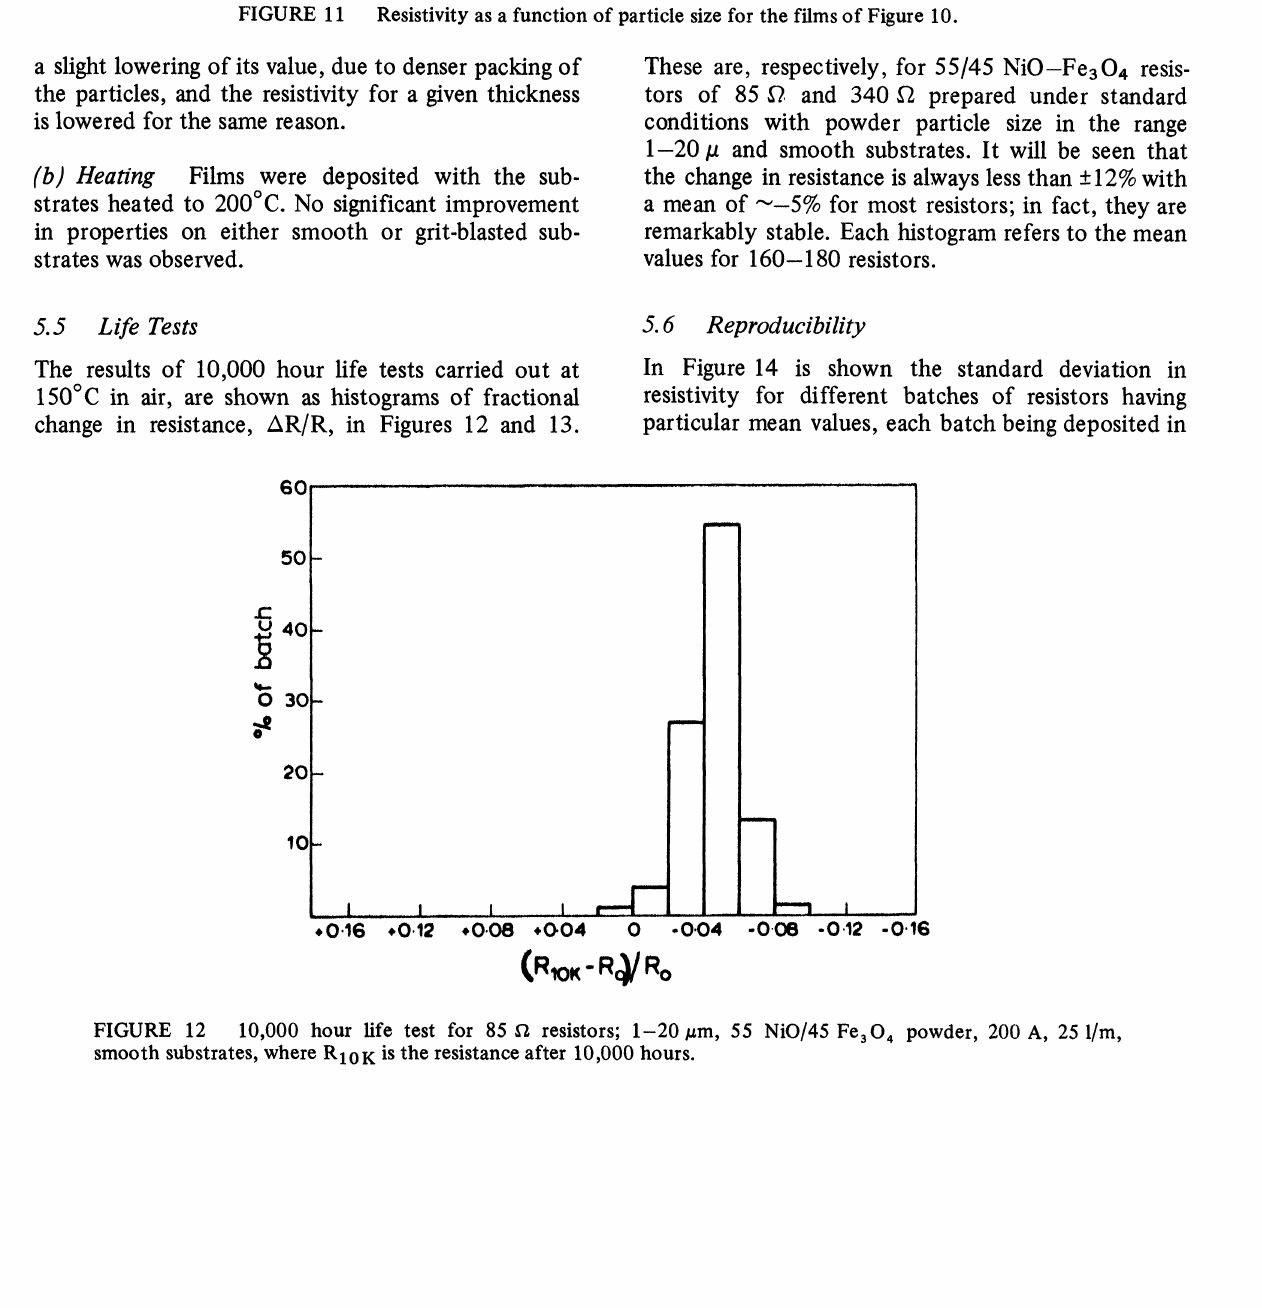
FIGURE 12 10,000 hour life test for 85 s2 resistors; 1-20 m, 55 NIO/45 Fe304 powder, 200 A, 25 l/m, smooth substrates, where R 10 K is the resistance after 10,000